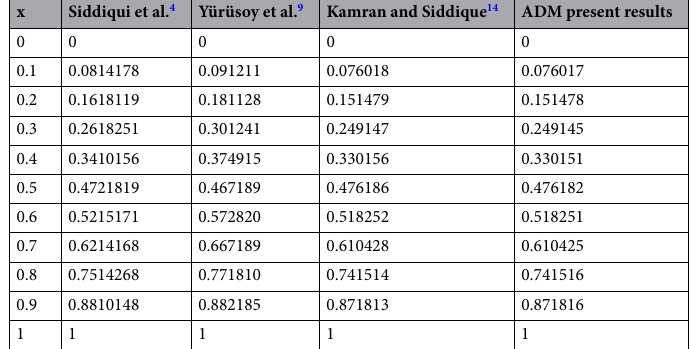
Table 1. Comparison of analytical results for the crisp velocity profile of Couette flow when β = 0.1, m = 0, p = − 0.5 and α -cut = 1.